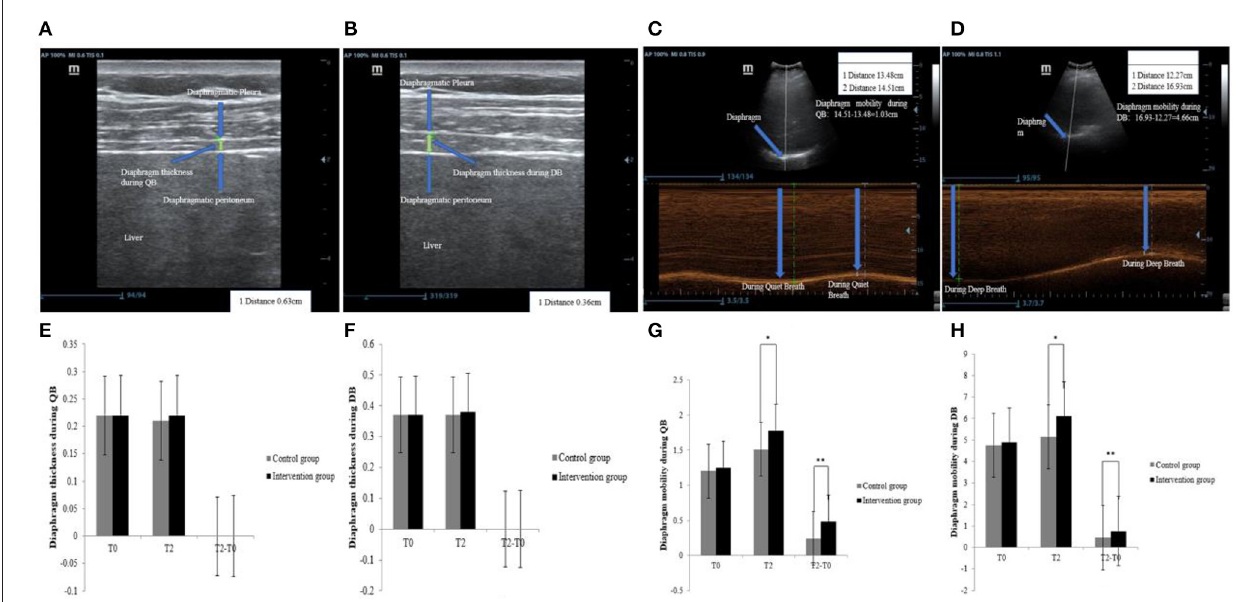
FIGURE 4 | Ultrasound and comparison of diaphragm thickness and mobility. (A) diaphragm thickness during QB, (B) diaphragm thickness during DB, (C) diaphragm mobility during QB, (D) diaphragm mobility during DB, (E) comparison of diaphragm thickness during DB, (F) comparison of diaphragm mobility during QB, (G) comparison of diaphragm mobility during QB, (H) comparison of diaphragm mobility during DB. QB, Quiet Breath; DB, Deep Breath; *Significant differences between groups ( P < 0.05); **The difference between groups was highly significant ( P < 0.01).